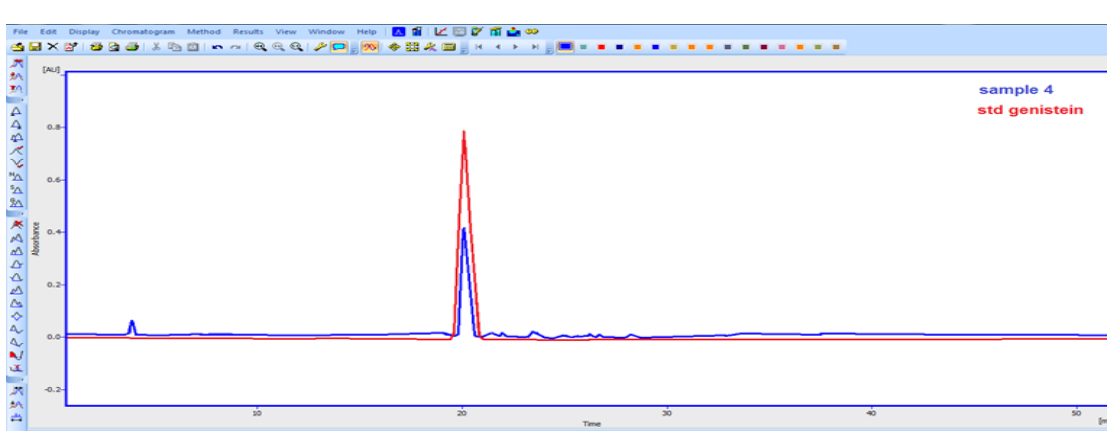
Figure 6. HPLC chromatogram of the isolated G compound &standard genistein